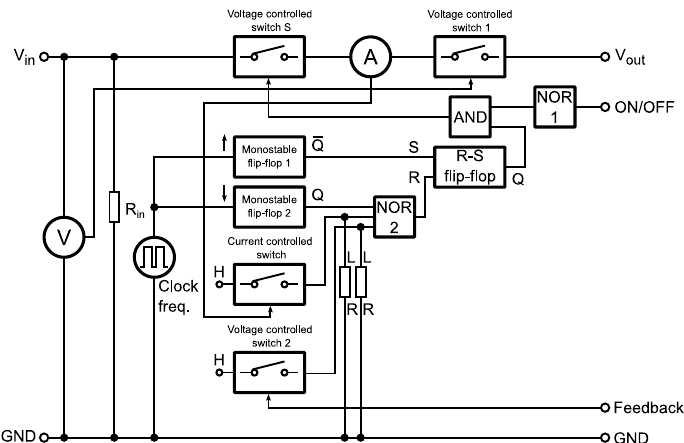
Figure 2. Block diagram of the proposed universal voltage regulator.